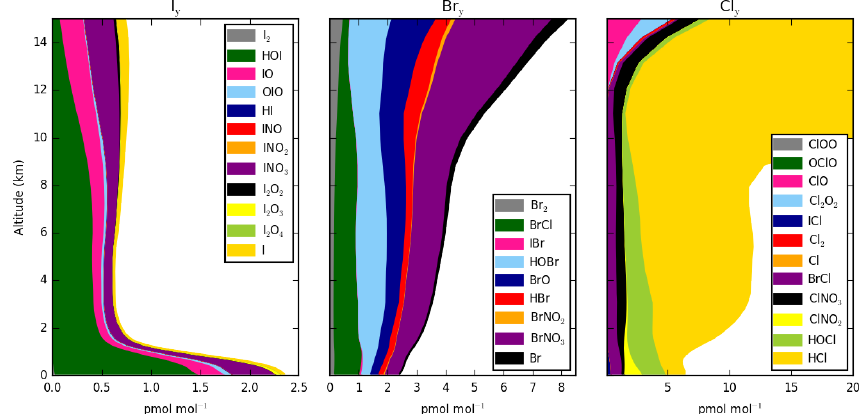
Figure 5. Modelled global average vertical X y ( X = Cl, Br, I) ( X y defined in Appendix C). Units are pmolmol − 1 of X (where X = Cl, Br, I). For Cl y the y axis is capped at 20pmolmol − 1 to show speciation. A Cl y maximum of 1062pmolmol − 1 is found within the altitudes shown due to additional HCl contributions increasing with altitude.